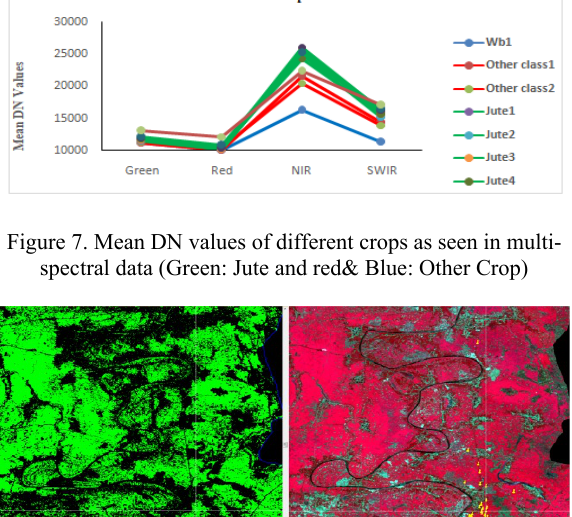
Figure 8. Jute classified image with reference FCC (Sentinel 2A) in Murshidabad District (West